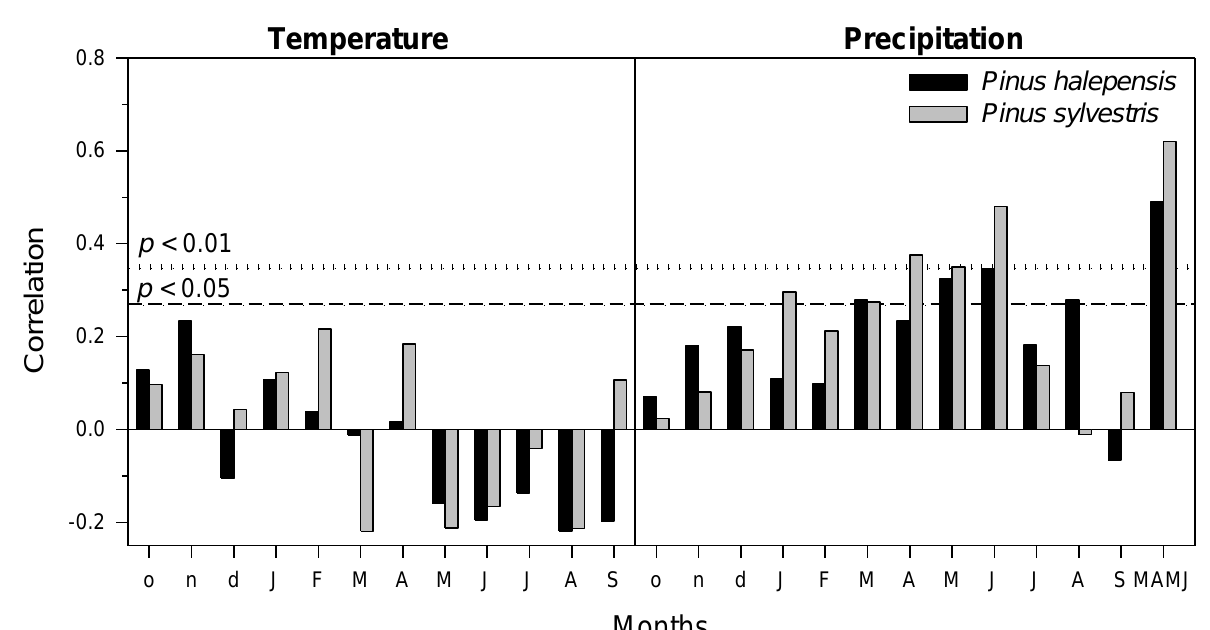
Figure 3. Climate-growth relationships based on Pearson correlations calculated by relating the residual chronologies of Pinus halepensis (black bars) and Pinus sylvestris (grey bars) and mean monthly temperature and precipitation. Dashed and dotes lines show the 0.05 and 0.01 significance levels, respectively. The last column corresponds to the accumulated precipitation form March to June (MAMJ), i.e., during the growing season. The correlations were calculated for the common, pre-windthrow period 1965–2016 (see Figure S3).